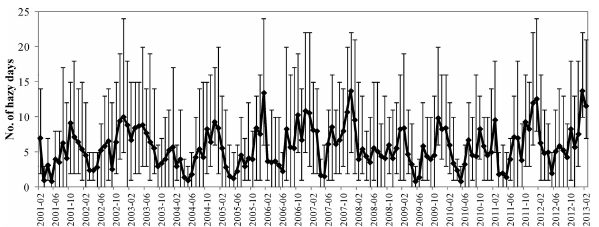
Fig. 2. The monthly average number of hazy days that occurred in the seven representative cities in Domain 2, including Shijiazhuang, Xingtai, Beijing, Tianjin, Taiyuan, Zhengzhou, and Jinan, during January 2001 to February 2013. The lines indicate the minimum and maximum number of hazy days in the seven cities.